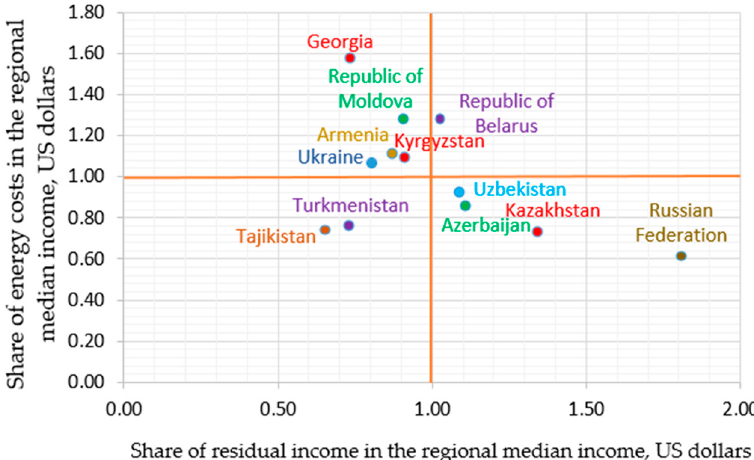
Figure 2. Assessment of the energy supply of the population of the EECCA countries (based on 60% of the regional median income after the deduction of fuel and housing costs). Source: authors’ elaboration.